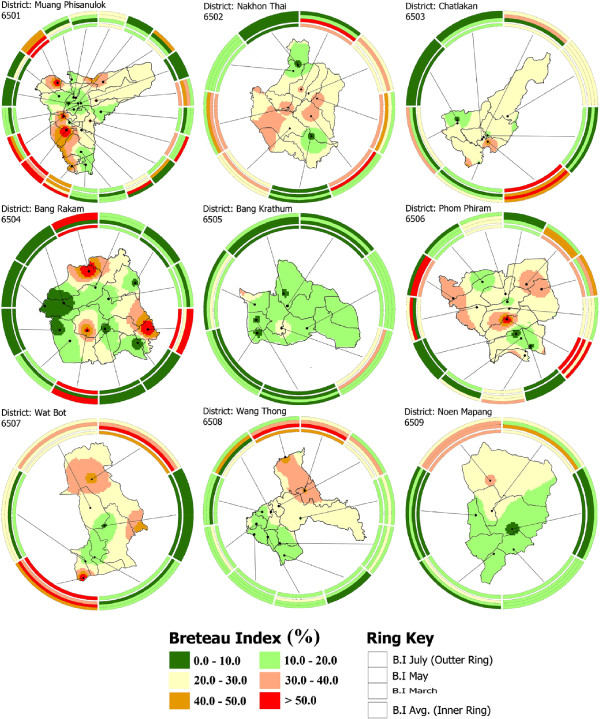
Relationships among dengue indices throughout the year in Phitsanulok (District-wise). Average B.I. (base map), average C.I. (inner ring) and average H.I. (outer ring), data was collected with the help of the Ministry of Public Health, Phitsanulok Province. Spokes around the base maps indicate the sampled village locations. The legend colors show the levels of B.I. from low (green) to high (red).